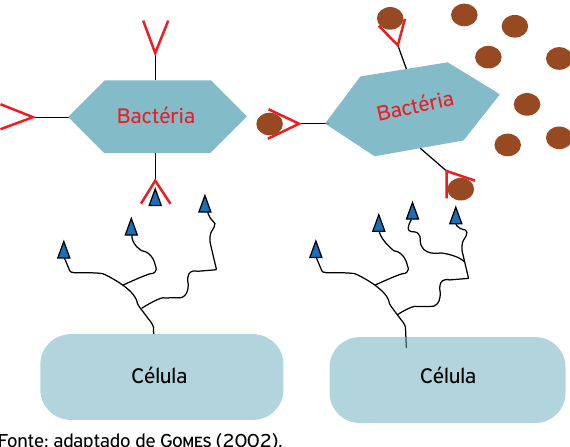
Figura 1. Composição e estrutura da parede celular da S. cerevisiae .